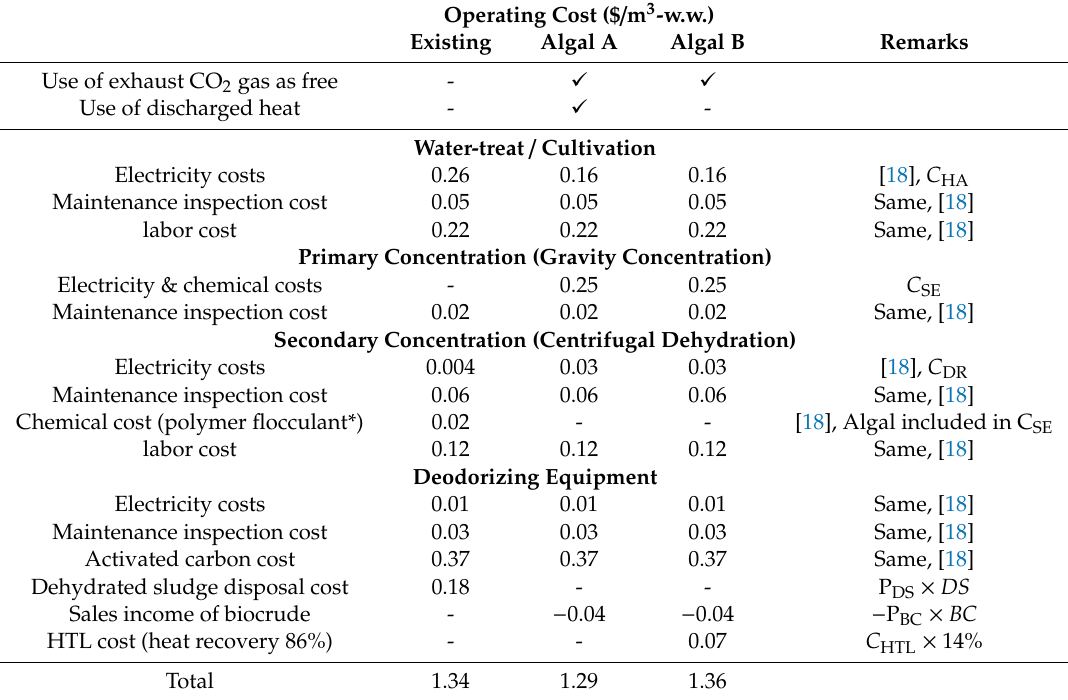
Table 2. Productivity in microalgal oil production from previous studies (No. 1–7) and applied values in this study (No. 8). Table A1. Operating costs for the existing OD method and microalgae scenario.